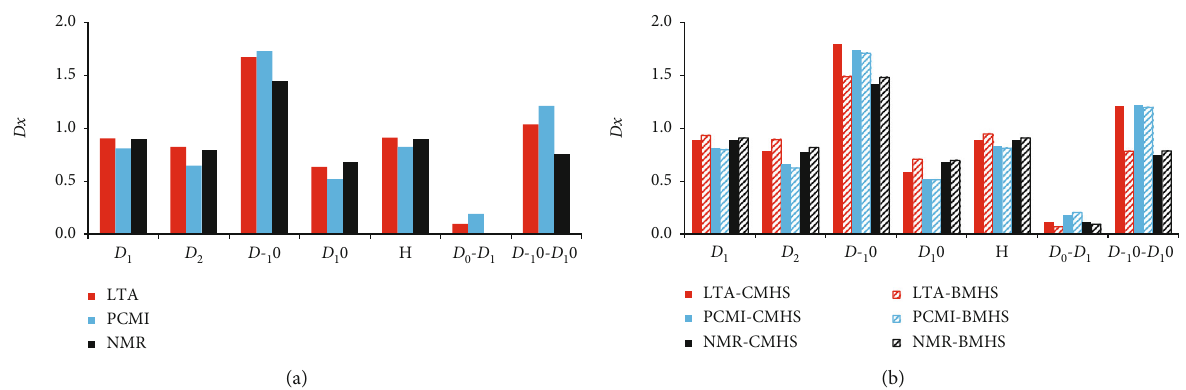
Figure 9: The comparison of multifractal dimension among (a) di ff erent methods and (b) di ff erent shale